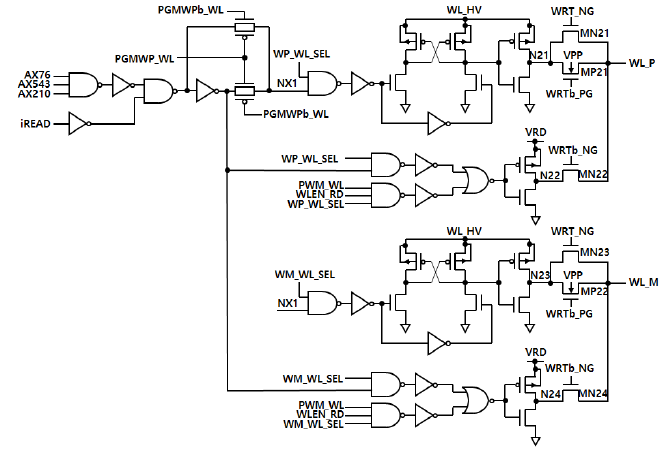
( b ) Figure 9. HV switching circuit used in synaptic core circuit: ( a ) WL_HV switching circuit; ( b ) PL_HV switching circuit. The WL driving circuit using WL_HV switching power is shown in Figure 10. Since WRT_NG, WRTb_PG, and WRTb_NG signals are set to 0 V, WL_HV, and 0 V in erase or program mode (Table 4), respectively, the voltage of nodes N21 (N23) is transferred to